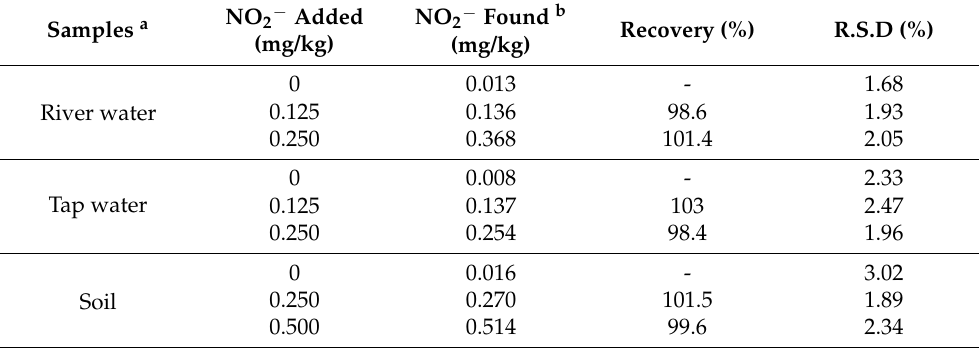
Table 1. Determination of NO 2 − in real water and soil samples using ESIPT-F. Samples a